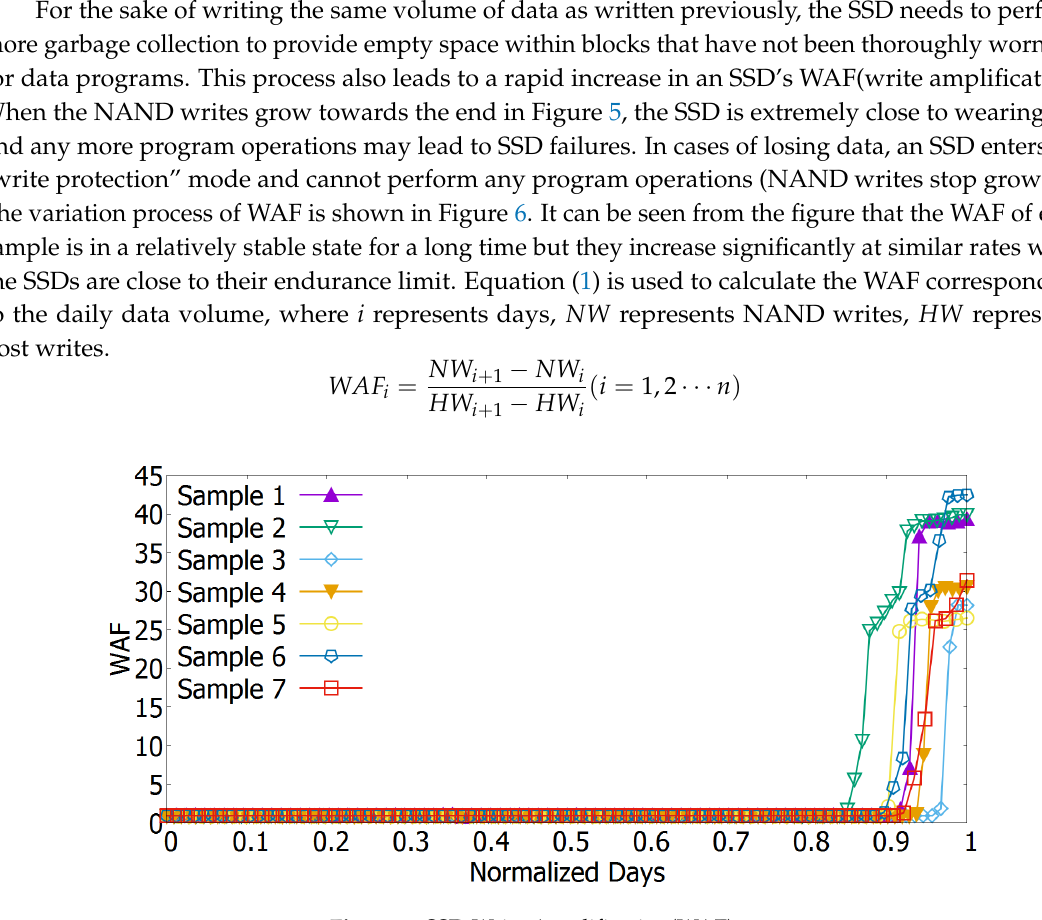
Figure 6. SSD Write